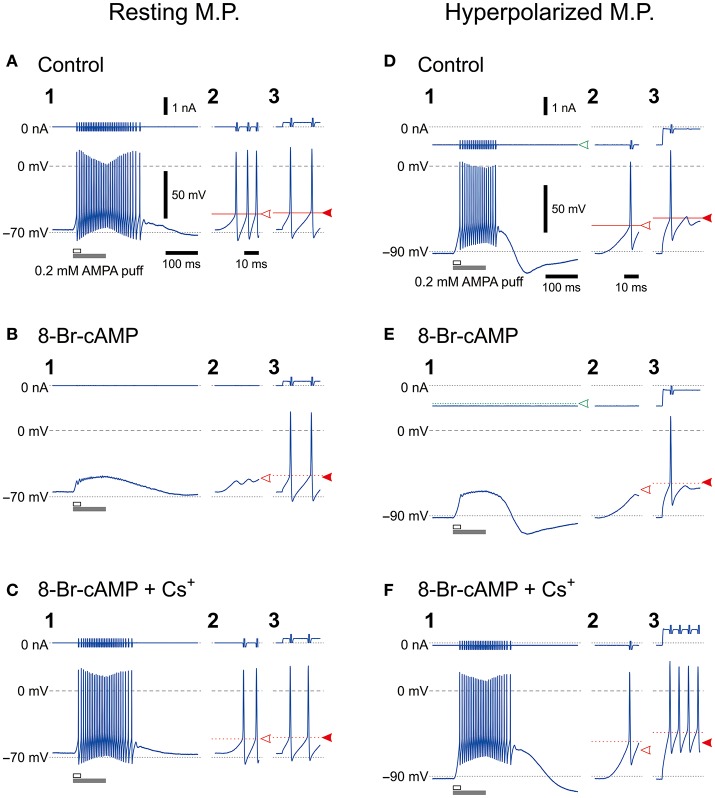
Effects of 8-Br-cAMP and Cs+ on spike firing induced by AMPA puff application or current pulse injection. Bottom, Membrane potential responses to a 100-ms puff of AMPA (1,2) or a 300-ms depolarizing current pulse (3) obtained before (A,D), during application of 8-Br-cAMP (B,E), and during the coapplication of 8-Br-cAMP and CsCl (C,F) under current-clamp conditions at baseline potentials of −70 mV (A–C) and −90 mV (D–F). Enlarged traces (2) seen during the respective time periods indicated with the open horizontal bars in 1. Top, Membrane currents. Panels labeled with 3 show the responses to the current pulses only for approximately 14 ms from the pulse onsets. Spikes that were evoked by current pulses were not affected by the possible shunting effects of Ih brought about by 8-Br-cAMP, which was consistent with the effects of 8-Br-cGMP that enhances leak K+ currents as well as Ih (Supplementary Figure 1). The calibrations in A1 also apply in all panels labeled with 1. The time calibration in A2 also applies in all panels labeled with 2 or 3.